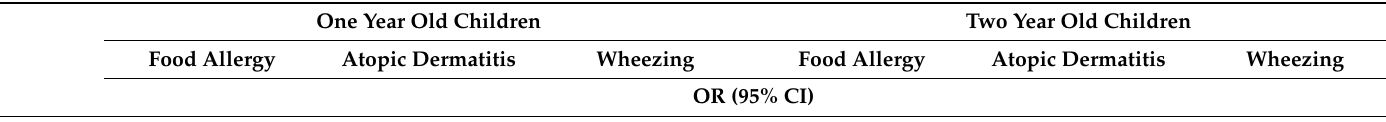
Table 5. Association between markers of oxidative stress in the 1st trimester of pregnancy, at delivery and umbilical cord blood stratified by maternal smoking status (active/passive smokers, non-smokers) and the risk of atopic dermatitis, food allergy or wheezing at the age of 1 and 2—the multivariable model.